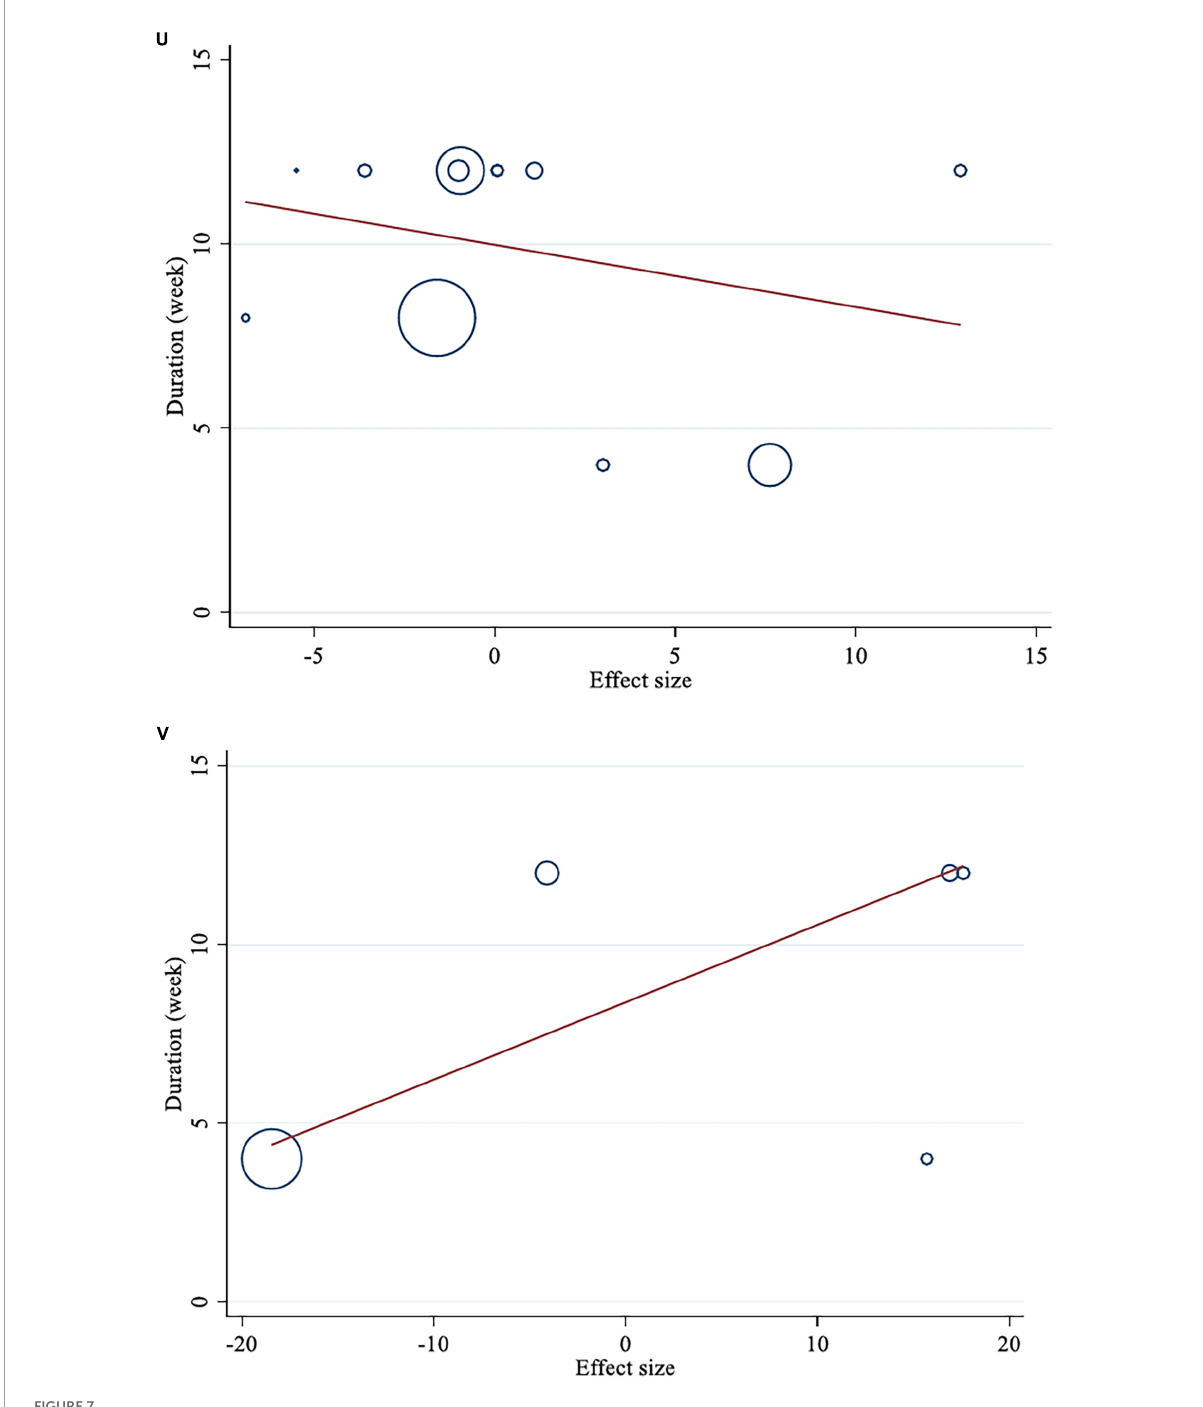
FIGURE7 Linear dose-response relations between saffron consumption and absolute mean differences. Dose-response relations between duration of intervention (week) and absolute mean differences (A) TG (mg/dl); (B) TC (mg/dl); (C) LDL (mg/dl); (D) HDL (mg/dl); (E) FBG (mg/dl); (F) Insulin (miu/ml); (G) HbA1c (%); (H) HOMA-IR; (I) SBP (mmHg); (J) DBP (mmHg); (K) CRP (mg/l); (L) ; IL-6 (pg/ml); (M) TNF- α (pg/ml); (N) weight (kg); (O) BMI (kg/m 2 ); (P) WC (cm); (Q) FM (%); (R) MDA (uM/L); (S) TAC (mM/L); (T) ALT (U/L); (U) AST (U/L) and (V) ALP (U/L). TG, triglyceride; TC, total cholesterol; LDL, low-density lipoprotein; HDL, high-density lipoprotein; FBG, fasting blood glucose; HOMA-IR, homeostasis model assessment for insulin resistance; HbA1C, hemoglobin A1C; CRP, C-reactive protein; IL-6, interleukin 6; TNF- α , tumor necrosis factor; TAC, total antioxidant capacity; BMI, body mass index; WC, waist circumference; FM, fat mass; ALT, alanine transaminase; AST, aspartate transaminase; ALP, alkaline phosphatase; MDA, malondialdehyde ; SBP, systolic blood pressure; DBP, diastolic blood pressure; CI, confidence interval; WMD, weighted mean